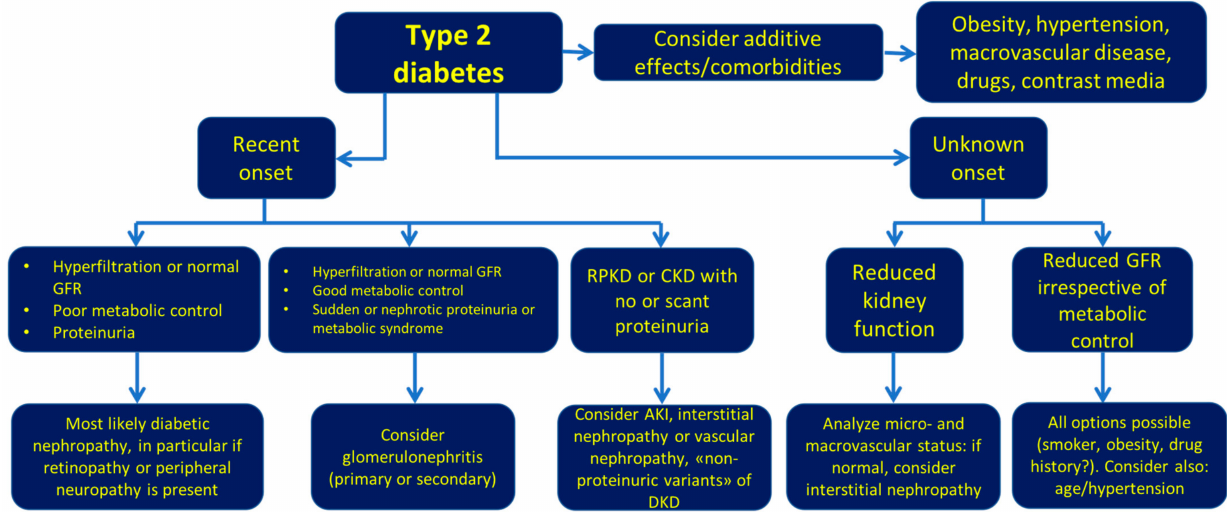
Figure 3. Diagnostic hypotheses flow-chart of diabetic kidney disease modified from [28]. Consider kidney biopsy in case of nephrotic proteinuria without retinopathy and in non-obese patients with sudden onset of proteinuria or stepwise increase of serum creatinine, in particular if the vascular status is well preserved and with no or scant proteinuria. RPKD: rapidly progressive kidney